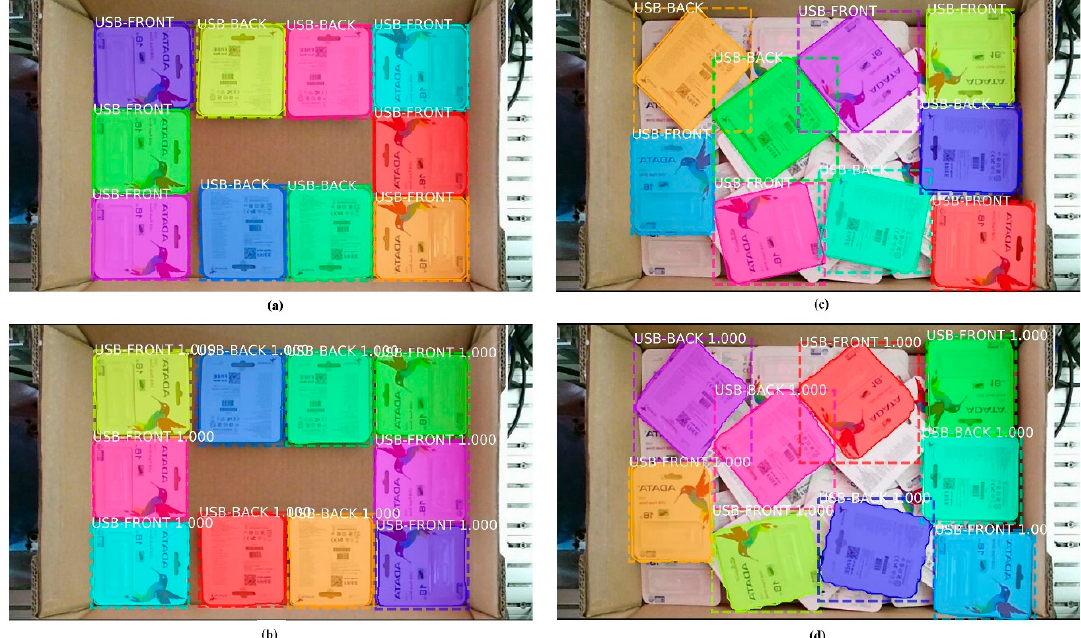
Figure 19. ( a , c ) Ground truth of two test cases; ( b , d ) the results of the prediction corresponded to two ground